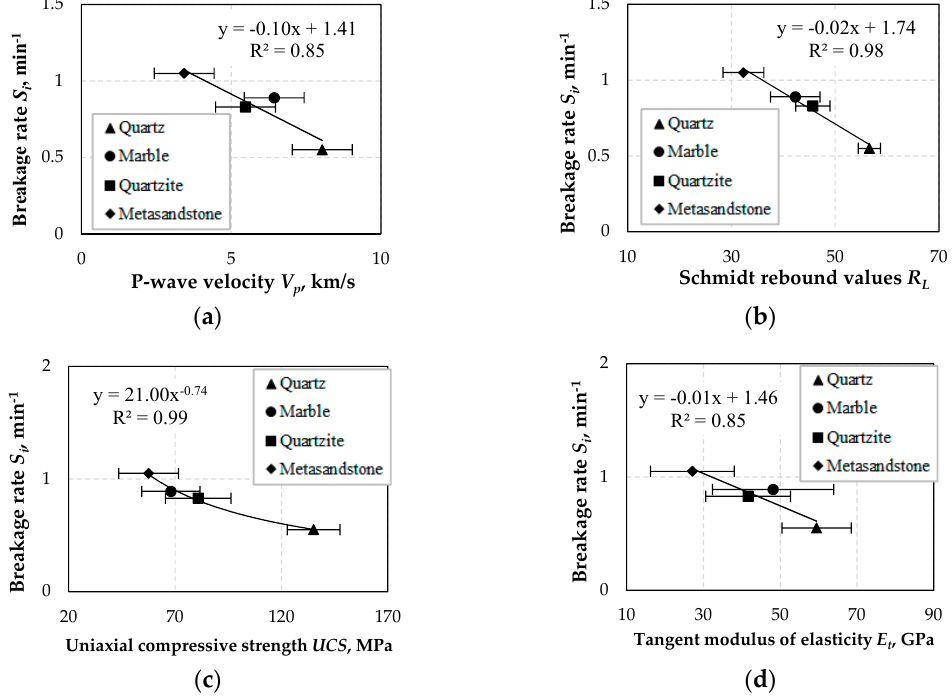
Figure 10. Correlations between breakage rate S i and ( a ) P-wave velocity V p , ( b ) Schmidt rebound values R L , ( c ) uniaxial compressive strength UCS and ( d ) tangent modulus of elasticity E t ; horizontal error bars show standard deviation of the measurements.